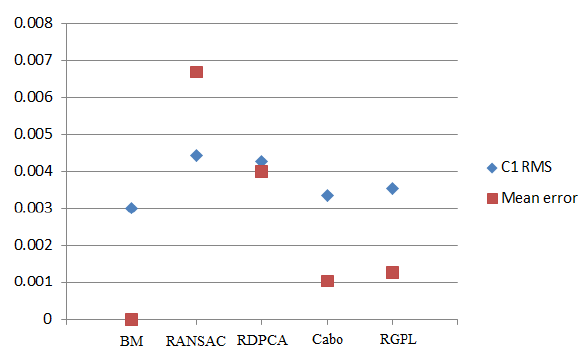
Figure 6 Mean errors and RMS value from different